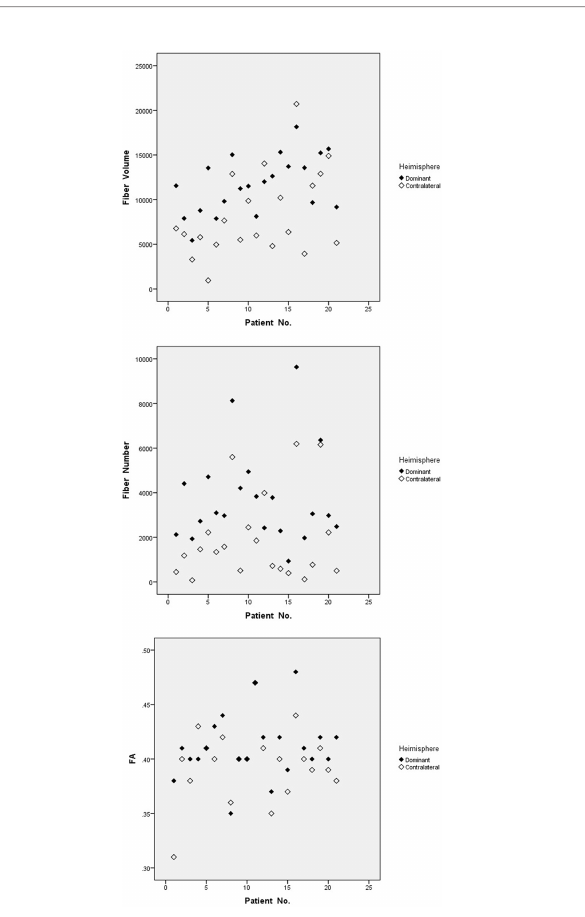
FIGURE 4 | Discrepant metrics of DTT between dominant and contralateral hemisphere. Fiber number, fi ber volume, and FA of AF show discrepant between DH and CH. FA, fractional